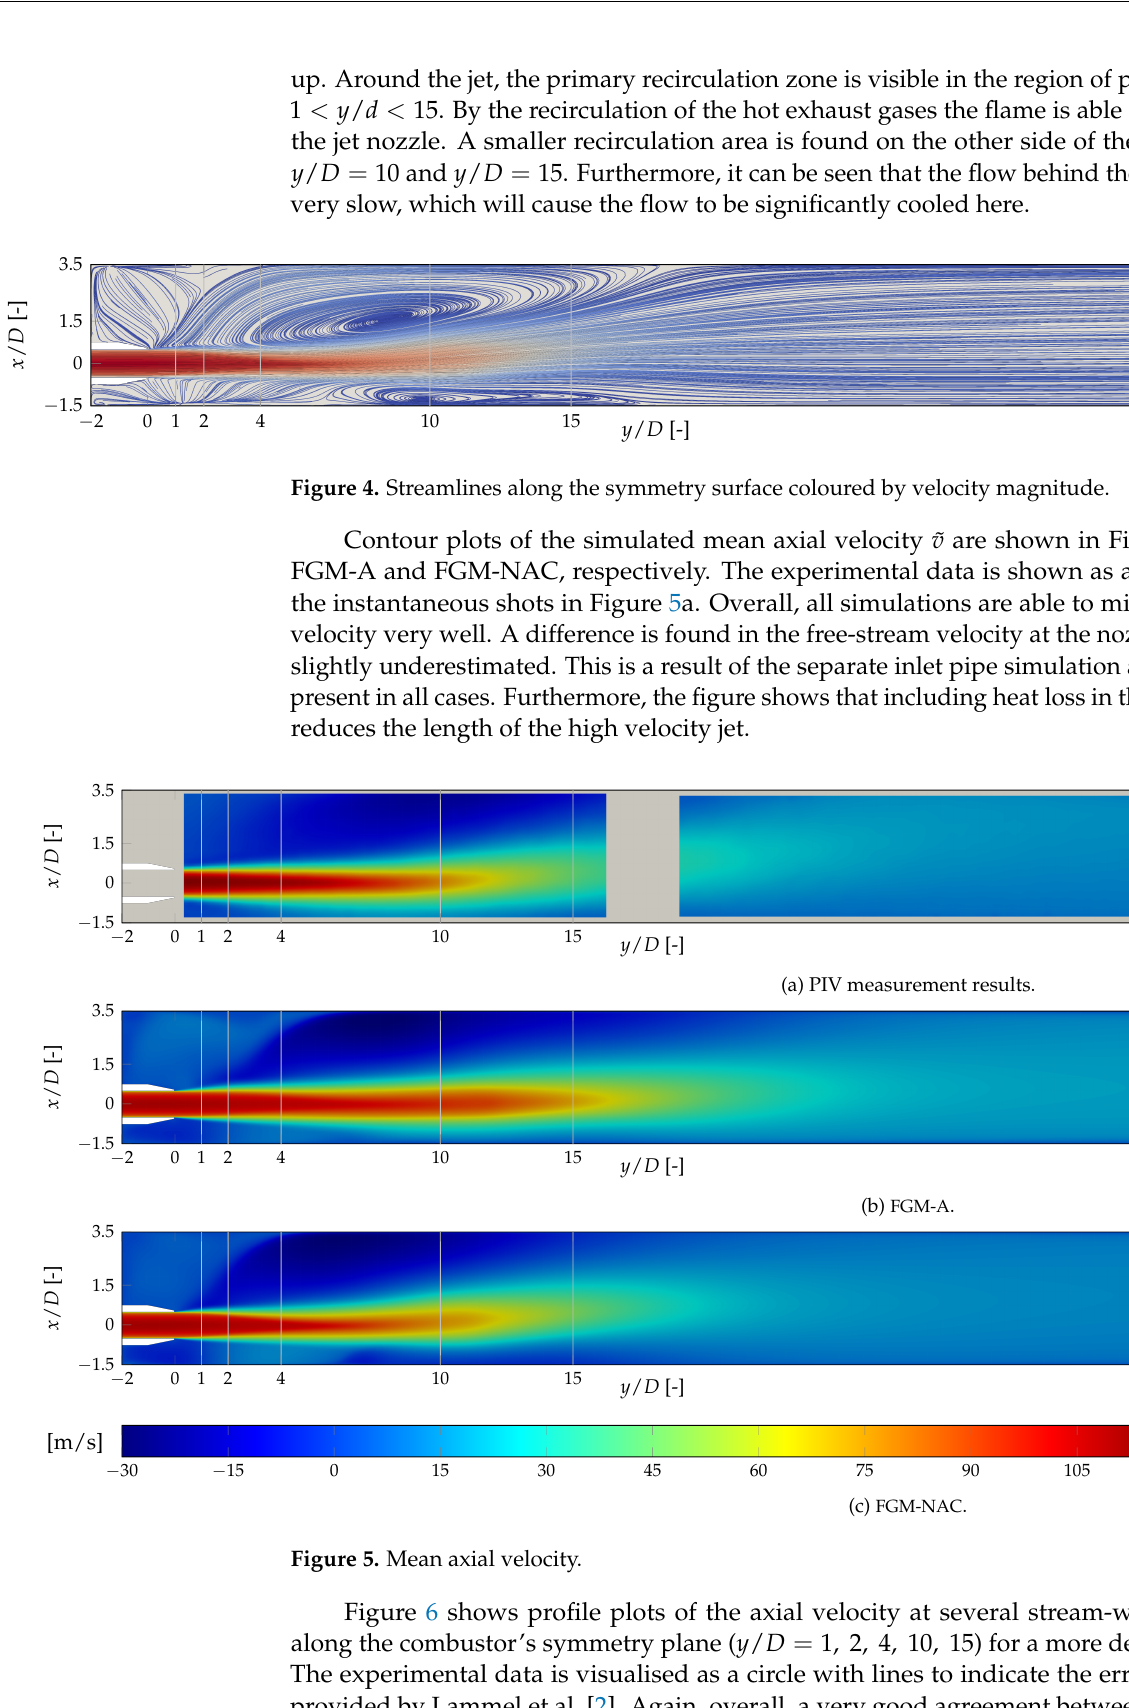
Figure 9. Mean axial velocity. Figure 5. Mean axial